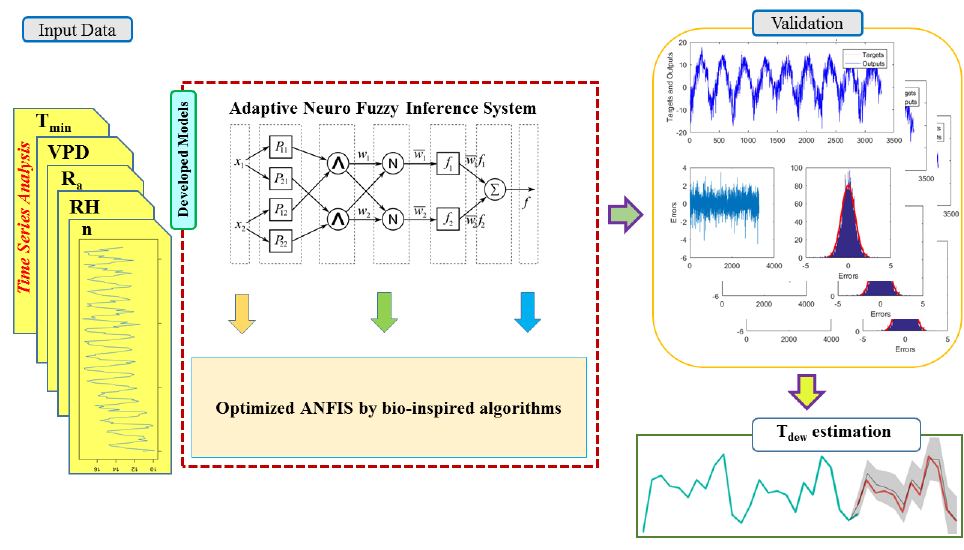
Figure 3. Schematic diagram of modeling process.